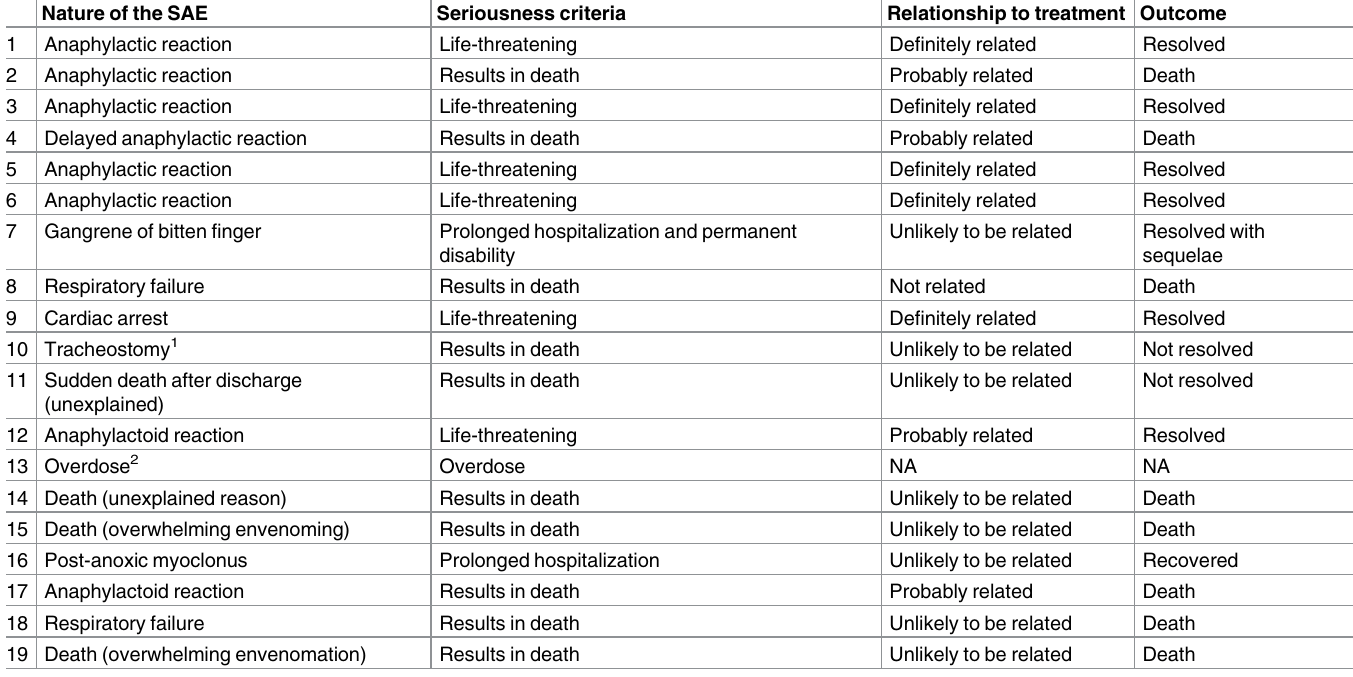
Table 5. List of serious adverseevents (SAE) occurring in snakebite victims with neurotoxic signs randomized to either a low or a high initial dose of